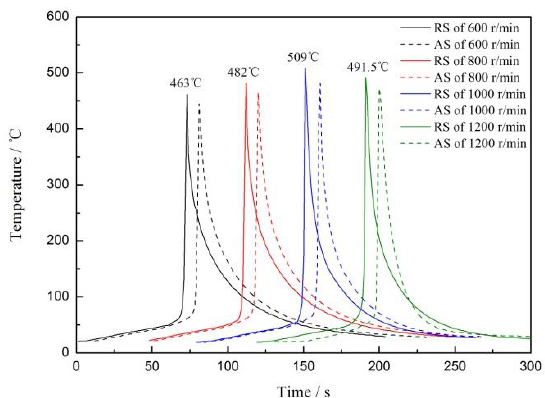
Figure 4. Welding thermal cycle curves at different rotational speeds. RS: retreating side; AS: advancing side.